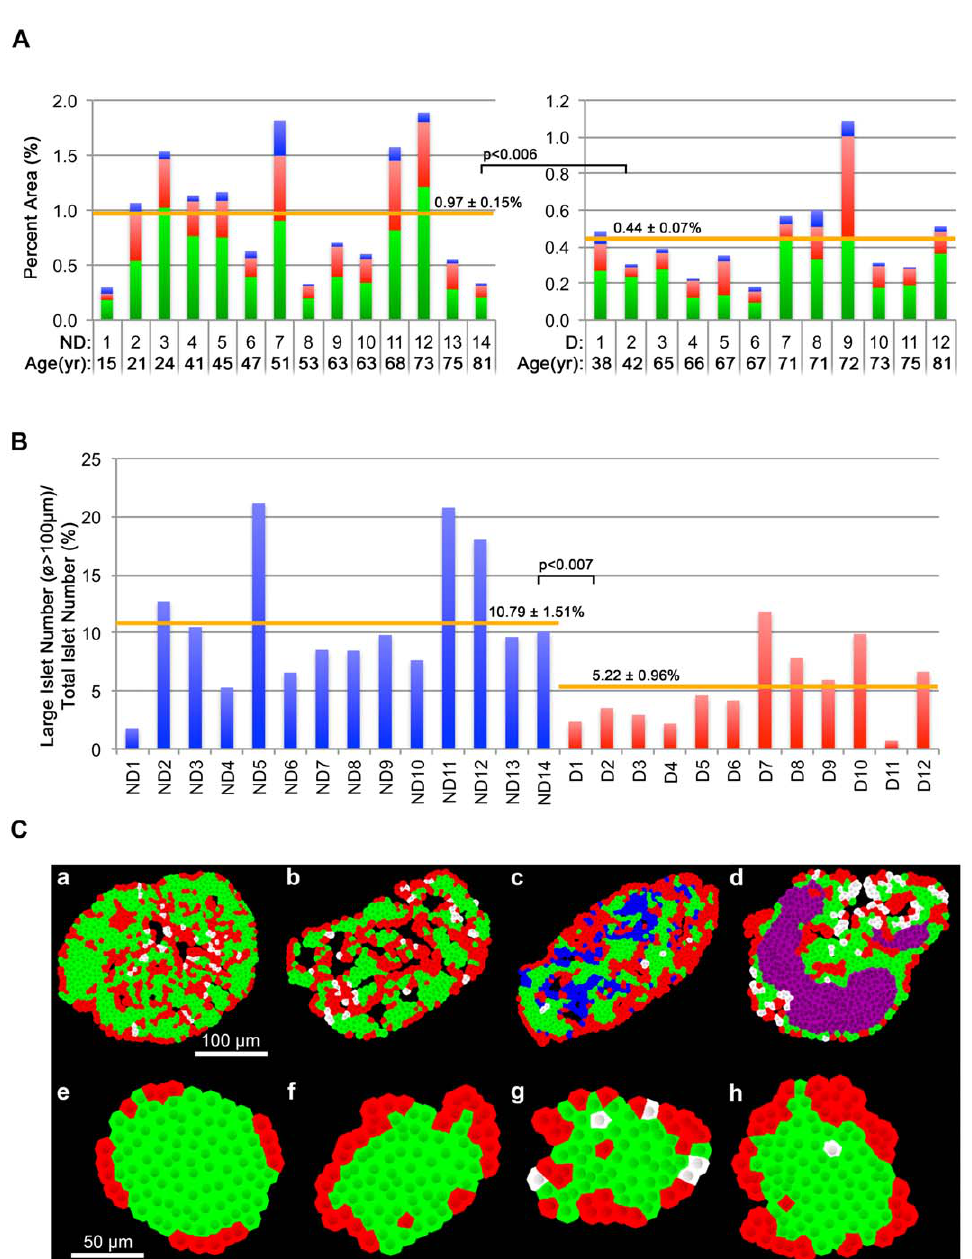
Figure 4. Endocrine cell mass and characteristics of islet architecture. A: Inter-subject comparison. Total islet cell composition (beta-cells in green, alpha-cells in red, and delta-cells in blue) in individual non-diabetic subjects (a) and T2D patients (b). B: Morphological changes observed in large islets. Representative islets are pseudo-colored models of actual islets based on immunohistochemical images composed of beta-cells (green), alpha-cells (red), and delta-cells (white). From left to right: compacted endocrine cell arrangement, relatively sparse architecture, the presence of a population of cells lacking cytosolic hormones (blue), and cyst formation containing necrotic materials (purple). Corresponding small islets from the same sections in a to d are shown in e to h .